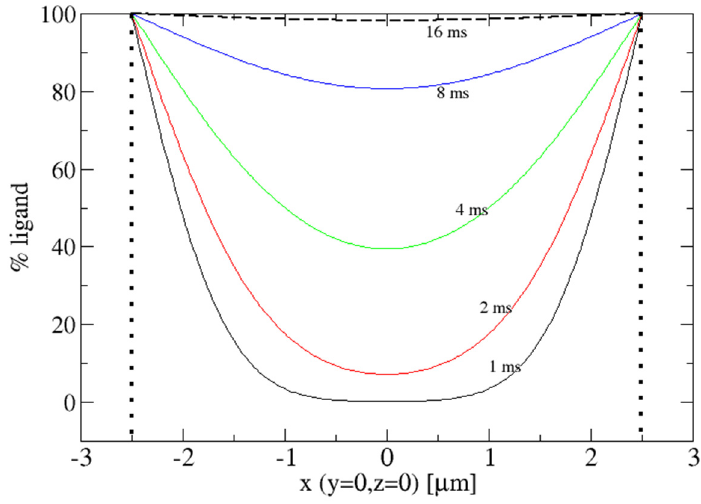
Figure 1. Concentration profile through the center of a 5 µ m shoe box crystal. The initial ligand concentration is assumed to be 100 % instantaneously outside the crystal. The diffusion coefficient of the ligand is 2.3 × 10 − 6 cm 2 / s. Equation (2) was solved with n, l, and m ranging from 0 to 20 and plotted across x, with y and z equal to 0.